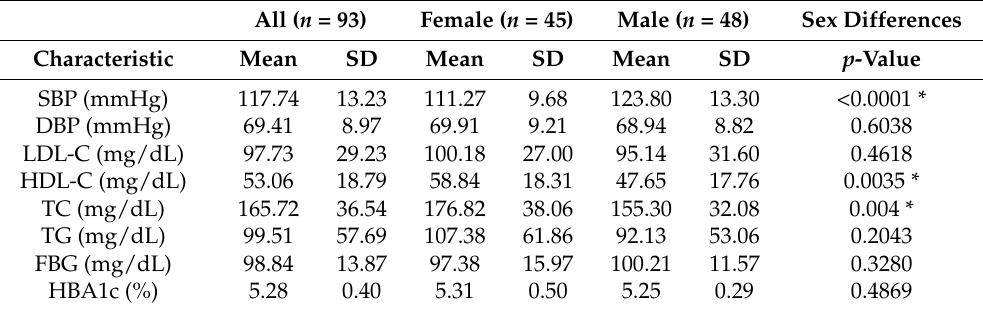
Table 3. Baseline biochemical measures by